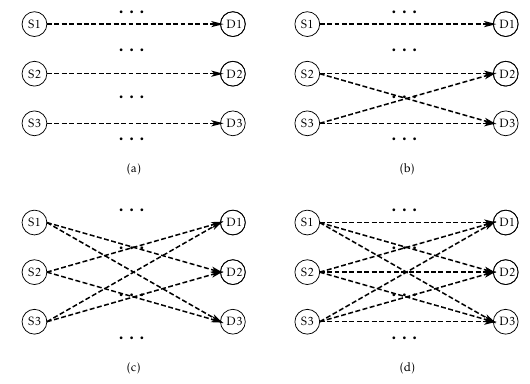
Figure 3. Message topology demonstration for the